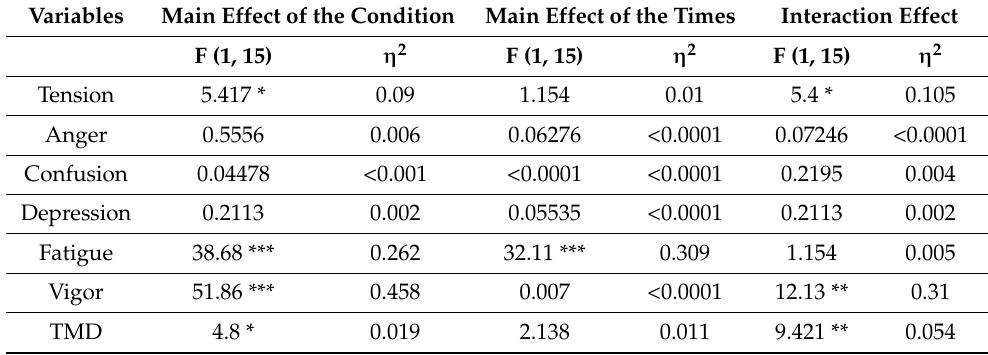
Table 3. POMS scores measured before and after small-sided games (SSG) with or without joker. Variables Main Effect of the Condition Main Effect of the